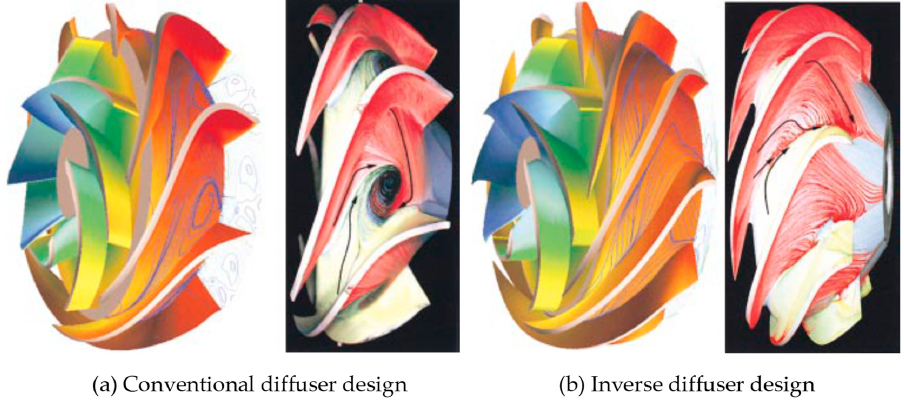
ff user design with suppressed corner stall Figure 9. Diffuser design with suppressed corner stall [34]. Figure 9. Di